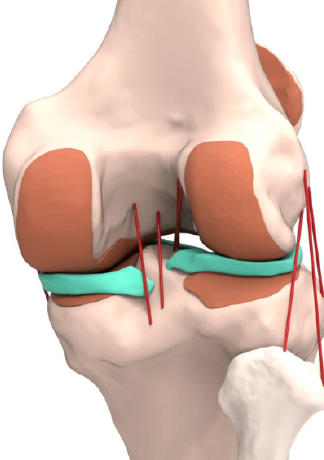
Figure 1. Developed three-dimensional finite element (3D FE) knee joint model from medical image.